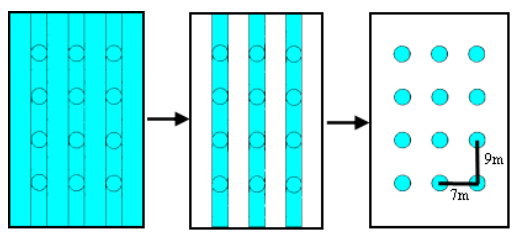
Figure 4. Arrangement and mining sequence of rooms and pillars.